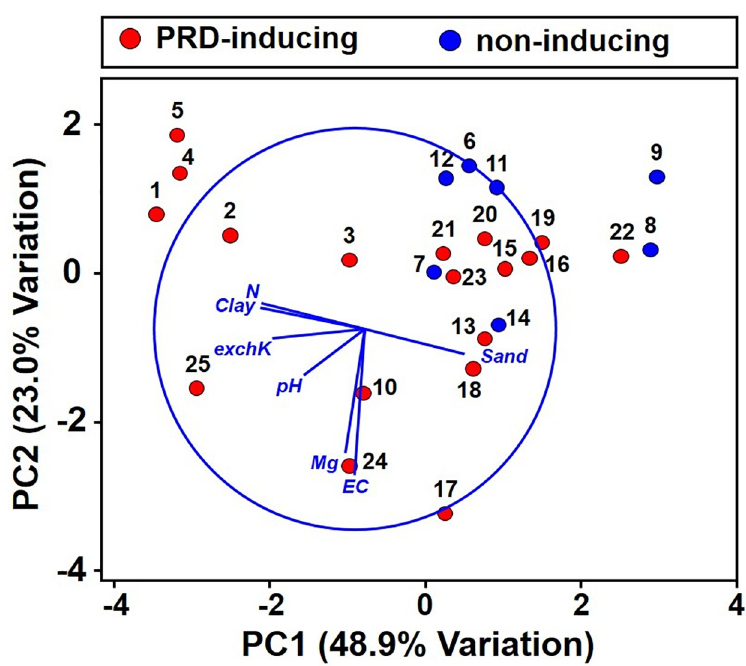
Fig 2. Principal component analysis of selected soil physicochemical variables among 25 soils. The numbers 1 to 25 correspond to soil numbers as listed in Table 1. Variables included were total % nitrogen (N); electrical conductivity (EC); exchangeable potassium (Exch-K); soluble magnesium (Mg), percent clay (clay), and percent sand (sand).